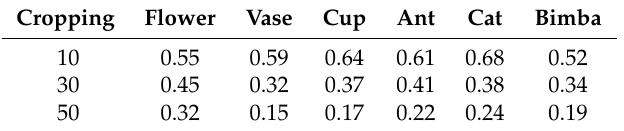
Table 12. Watermark robustness against cropping measured in terms of correlation.